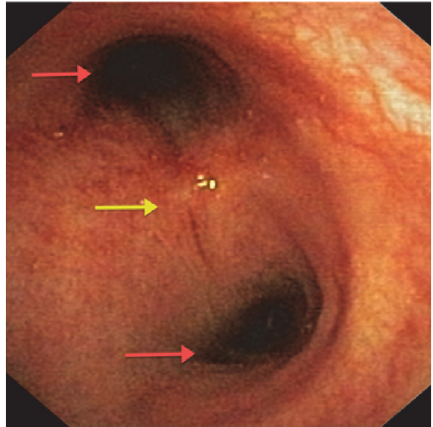
Figure 4: Bronchoscopy: broadened carina with compression of the main